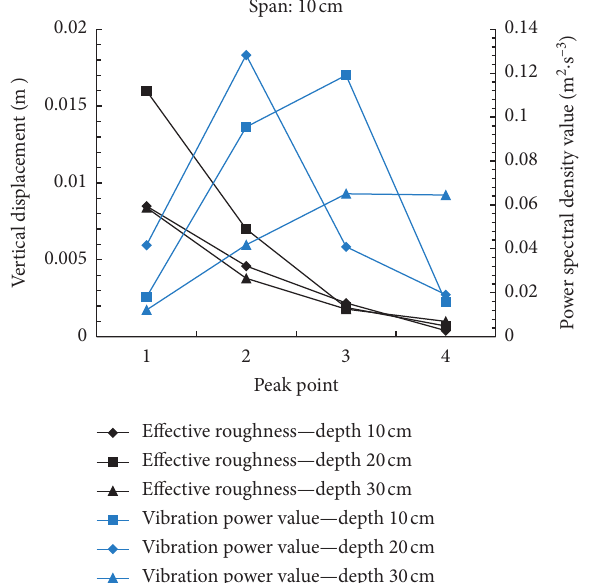
Figure 13: Vertical displacement of vibration power value and effective roughness corresponding to peak